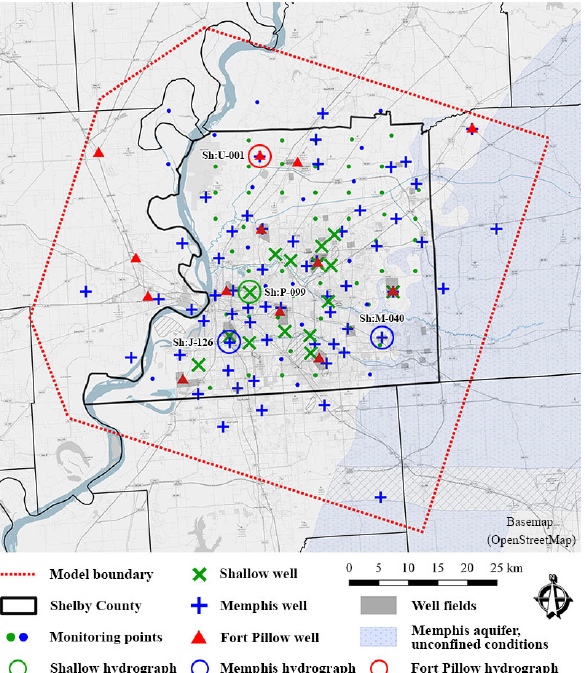
Figure 10. Monitoring wells and points used in the calibration process. Circled monitoring wells were used in a hydrograph analysis (ref. Figure